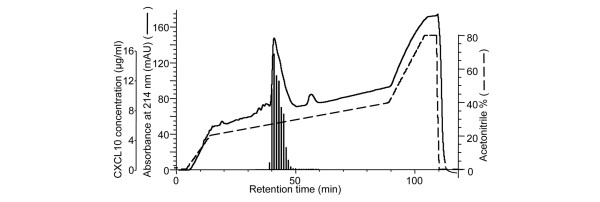
Reverse-phase HPLC purification of fibroblast-derived CXCL10. Semi-purified fibroblast-derived CXCL10 was subjected to C8 reverse-phase HPLC. Proteins were eluted in an acetonitrile gradient (dashed line) and UV absorbance was detected at 214 nm (solid line). CXCL10 immunoreactivity in the column fractions was detected by ELISA (histograms).